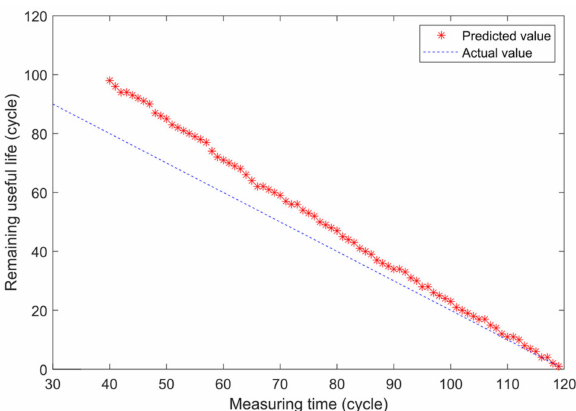
Figure 9. Predicted value and actual value of URL with fixed degradation threshold.